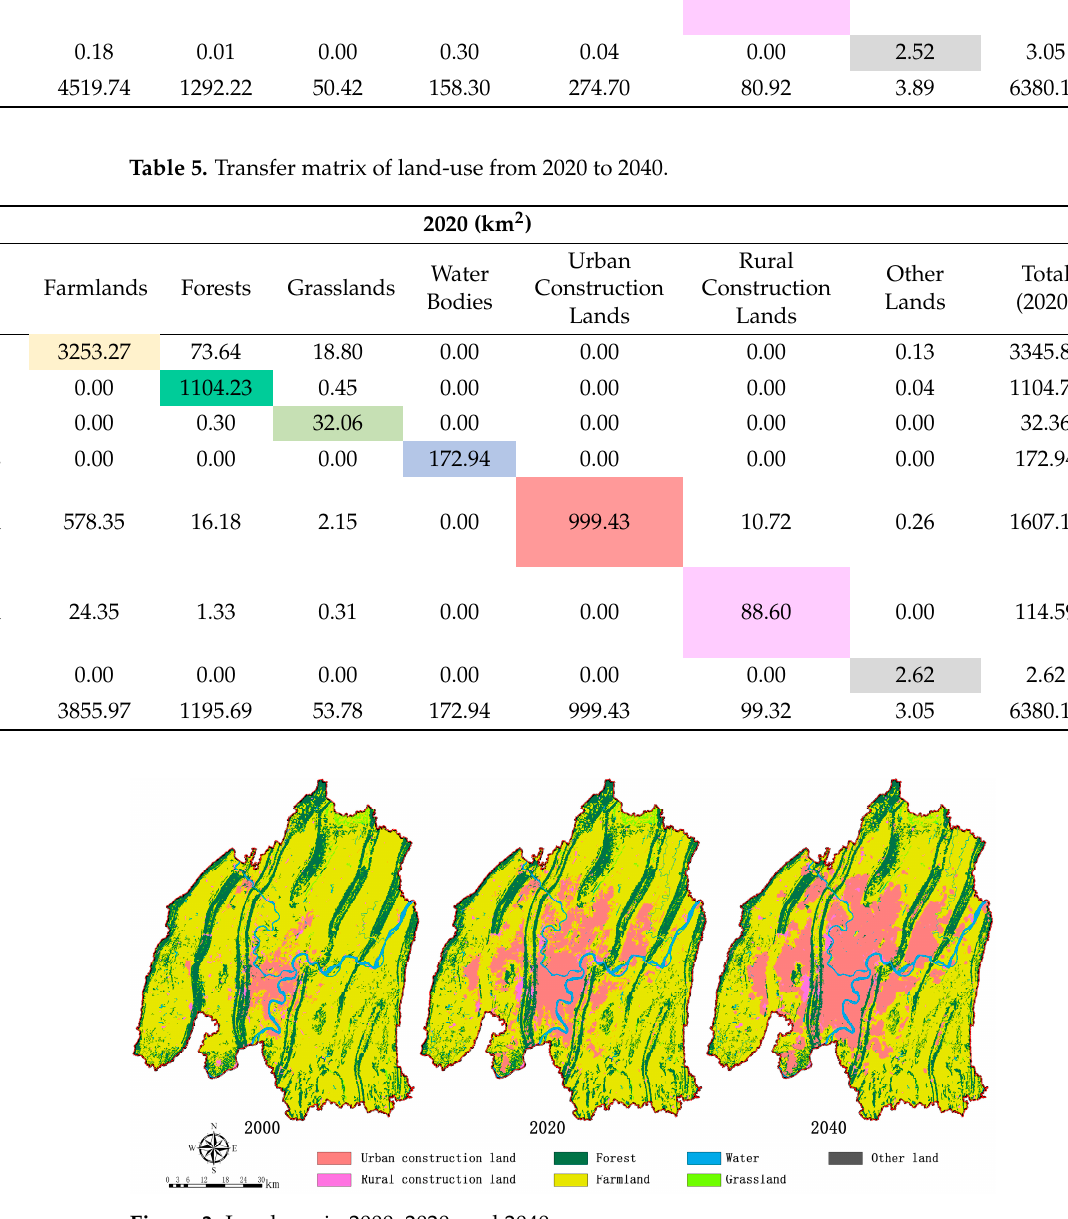
Figure 3. Land-use in 2000, 2020, and